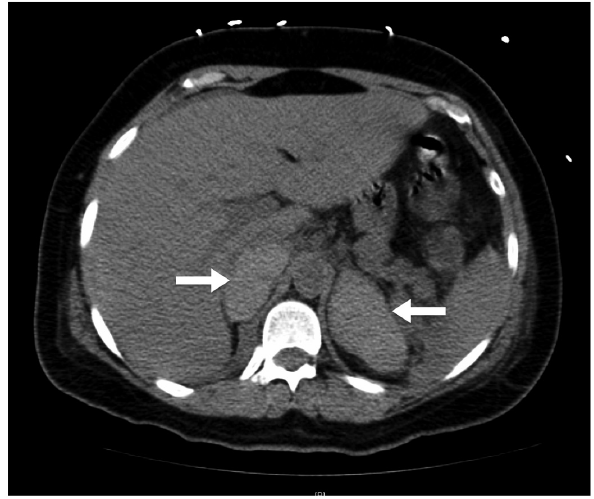
Figure 1. Non-contrast computed tomography scan of adrenal glands. CT scan of adrenal glands; white arrows indicate severely enlarged, hyperdense, adrenal glands bilaterally consistent with adrenal hemorrhage. With their rich arterial supply and single central vein, the adre- nal glands are particularly susceptible to congestive hemorrhage following venous thrombosis. Adrenal hemorrhage associated with HIT tends to be bilateral, resulting in severe clinical manifestations from abdominal pain, fever and lethargy, to catastrophic hemody- namic collapse 2 . In the post-surgical patient, these symptoms can be confused with more common complications, such as sepsis or hemorrhage. As undiagnosed cases tend to be fatal, a prompt rec- ognition is crucial 2